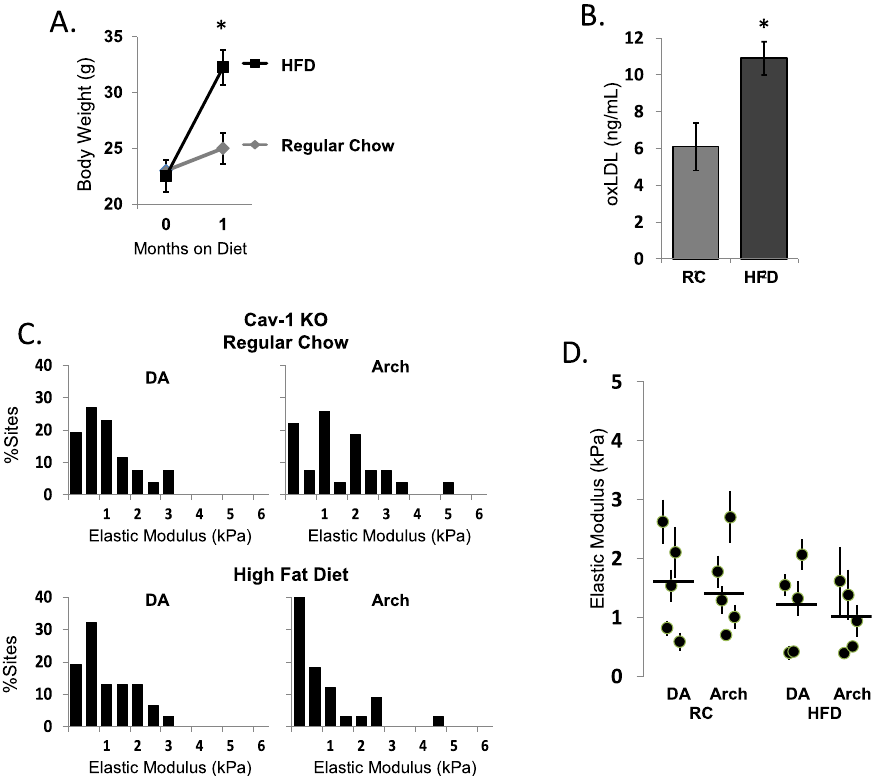
Figure 5. Absence of caveolin-1 abrogates endothelial stiffening induced by high fat diet. ( A,B ) Increase in body weight and plasma concentration of oxLDL in Cav-1 KO mice fed a HFD for 1 month. ( C ) Histograms of elastic modulus of DA and Arch in Cav-1 KO male mice fed regular chow (RC) or HFD for 1 month. ( D ) Summary of aortic elastic modulus recordings in Cav-1 KO mice. *P < 0.05 by